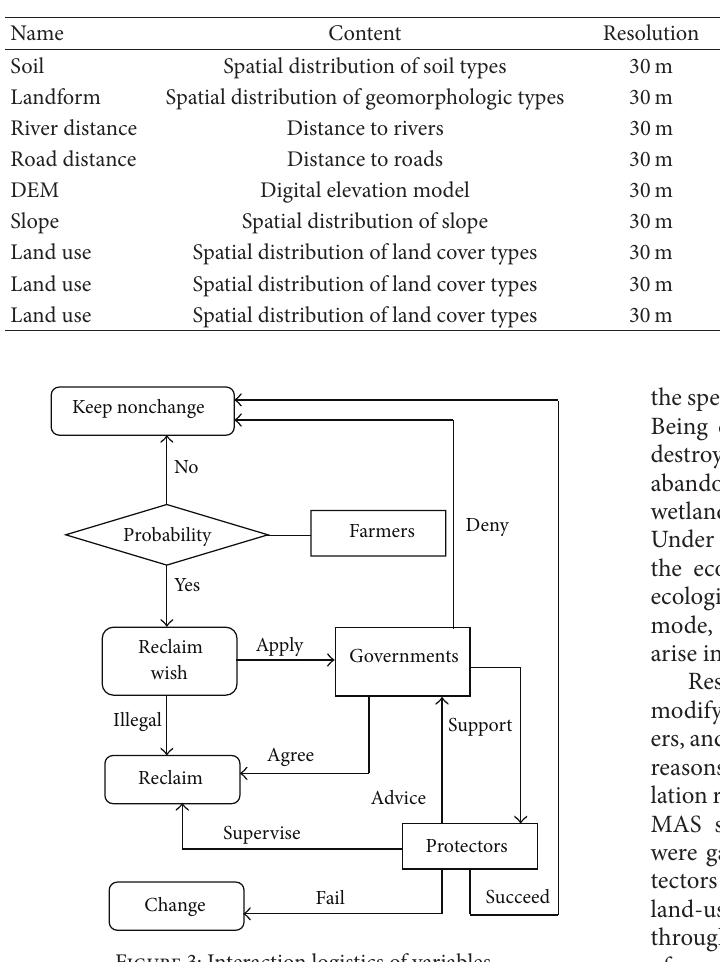
Table 1: List of data description.